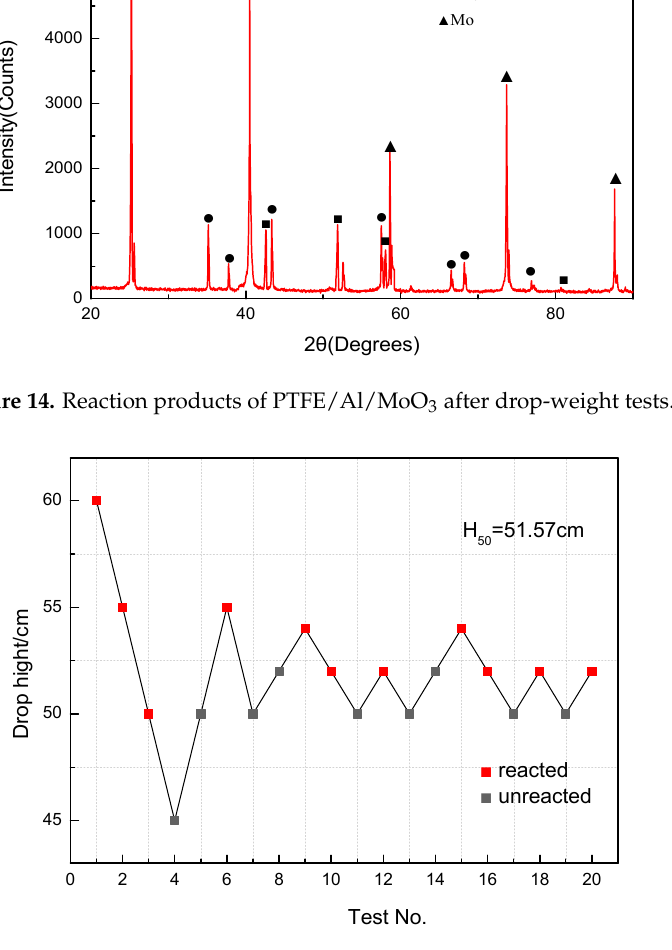
Figure 15. The drop-weight tests data points.